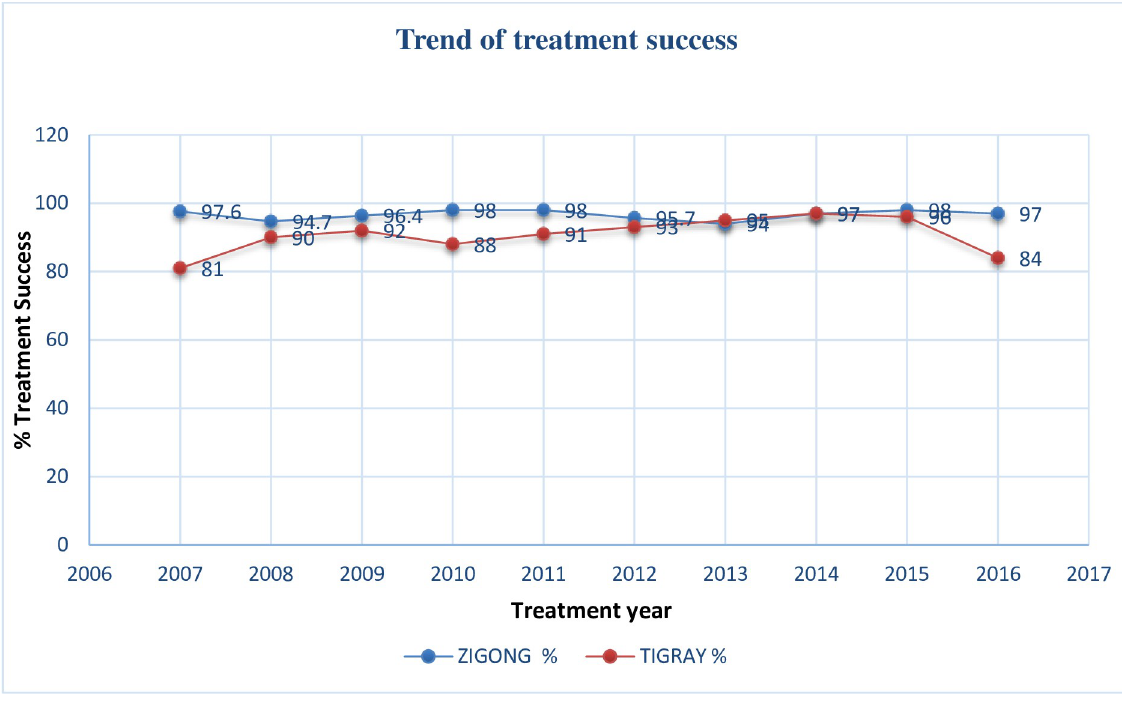
Fig 1. Trend of women treatment success in Tigray and Zigong January 2007–December 2016 N = 2084 and N = 4047.